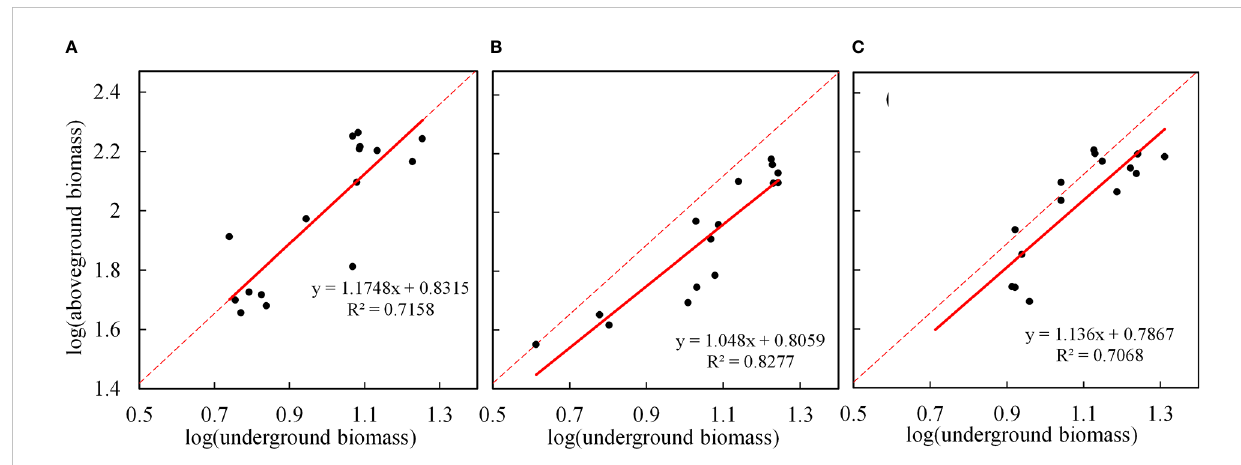
FIGURE 7 Allometric growth relationship between underground and aboveground biomass summer maize under different drought conditions. (A – C) are fi tted for the allometric growth of the CS, LD, and MD, respectively. The red solid line represents the linear fi tting under different drought scenarios, and the red dotted line represents the linear fi tting of the